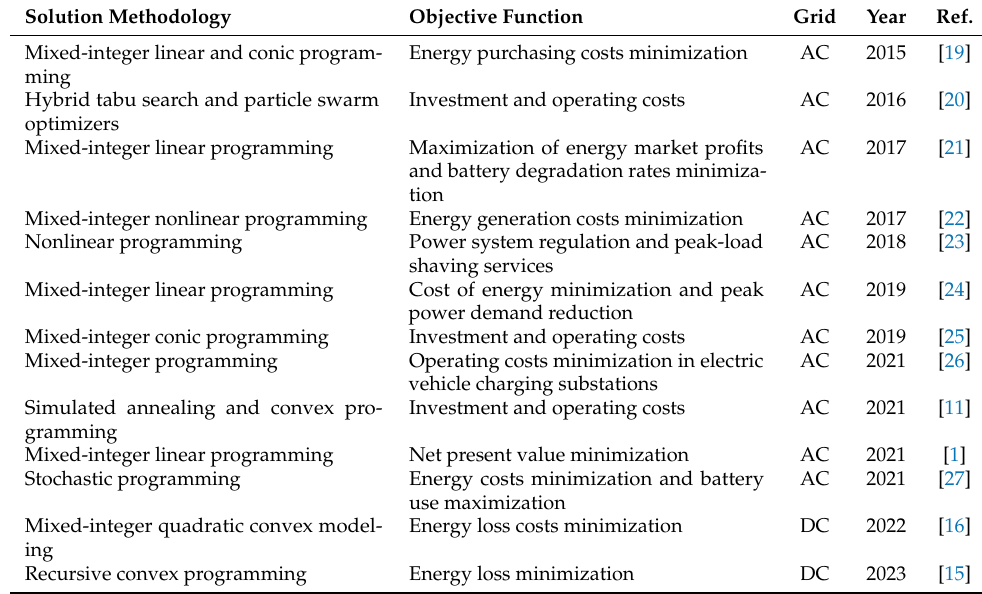
Table 1. Summary of the main the literature approaches regarding the integration and operation of BESS in electrical